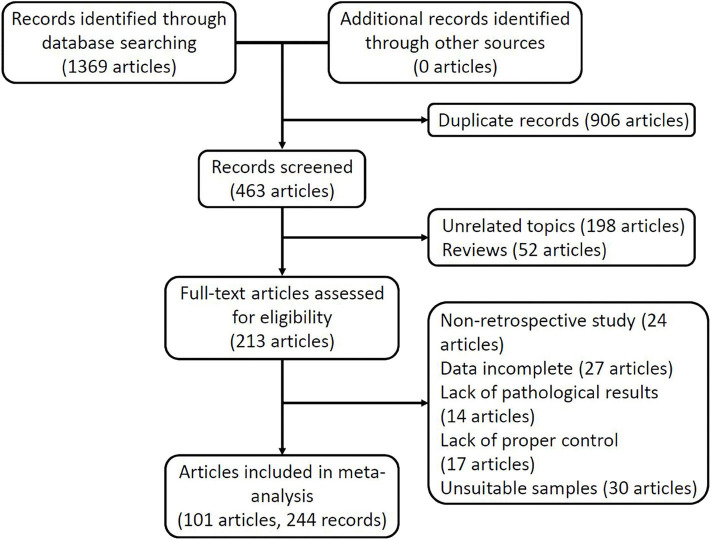
PRISMA flow diagram of the study selection process.